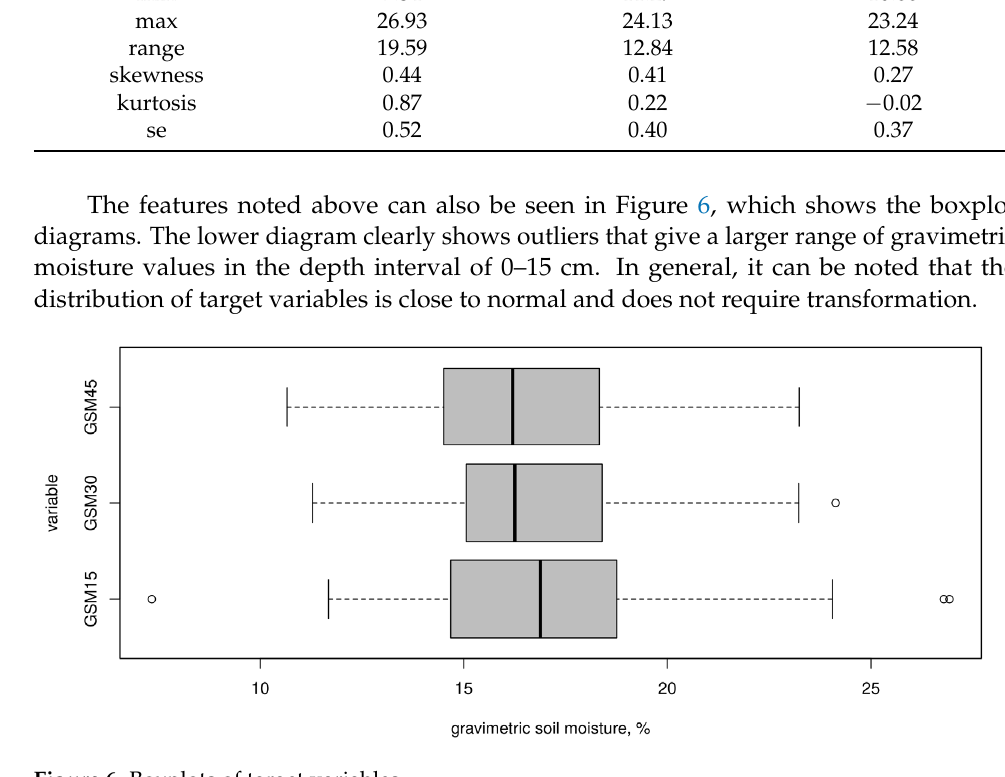
Figure 6. Boxplots of target variables.